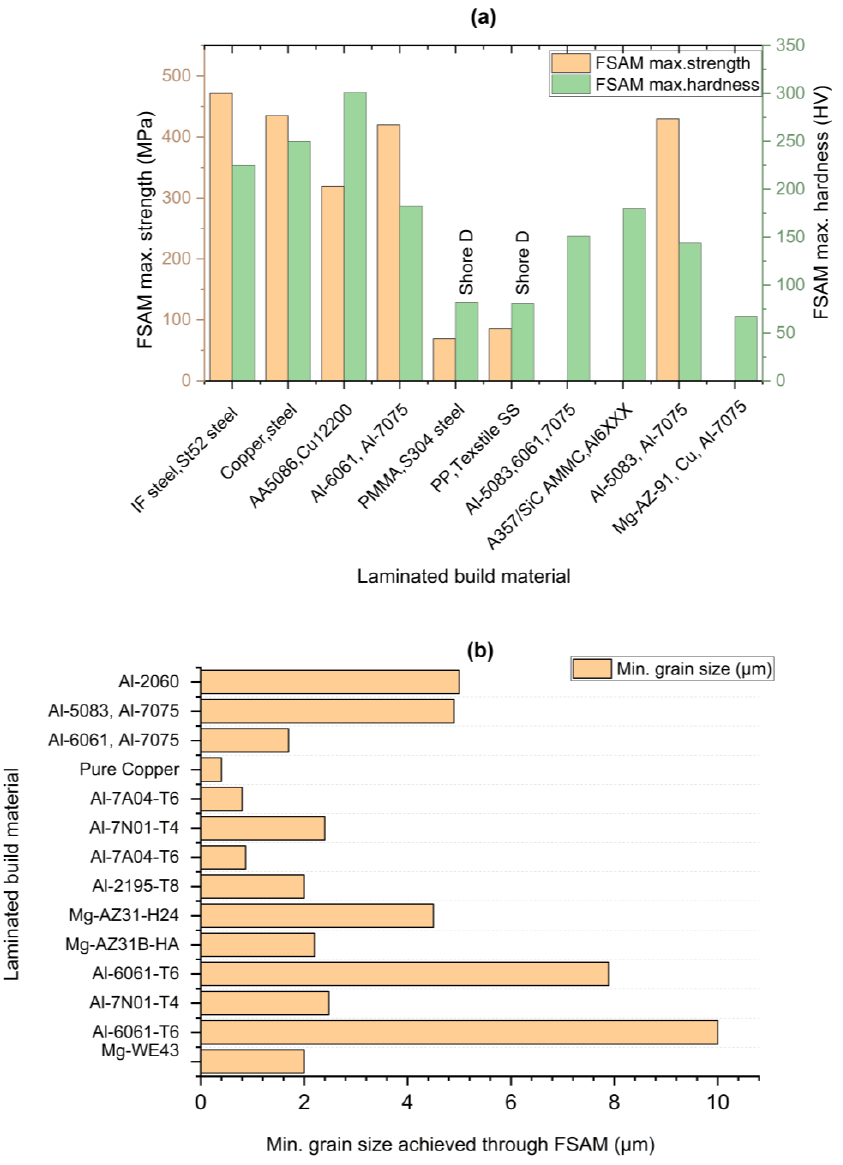
Figure 19. Overall mechanical properties summary (discussed above): ( a ) maximum strength and hardness of multi-material laminates; ( b ) minimum grain size achieved (both identical and multi- material laminates.